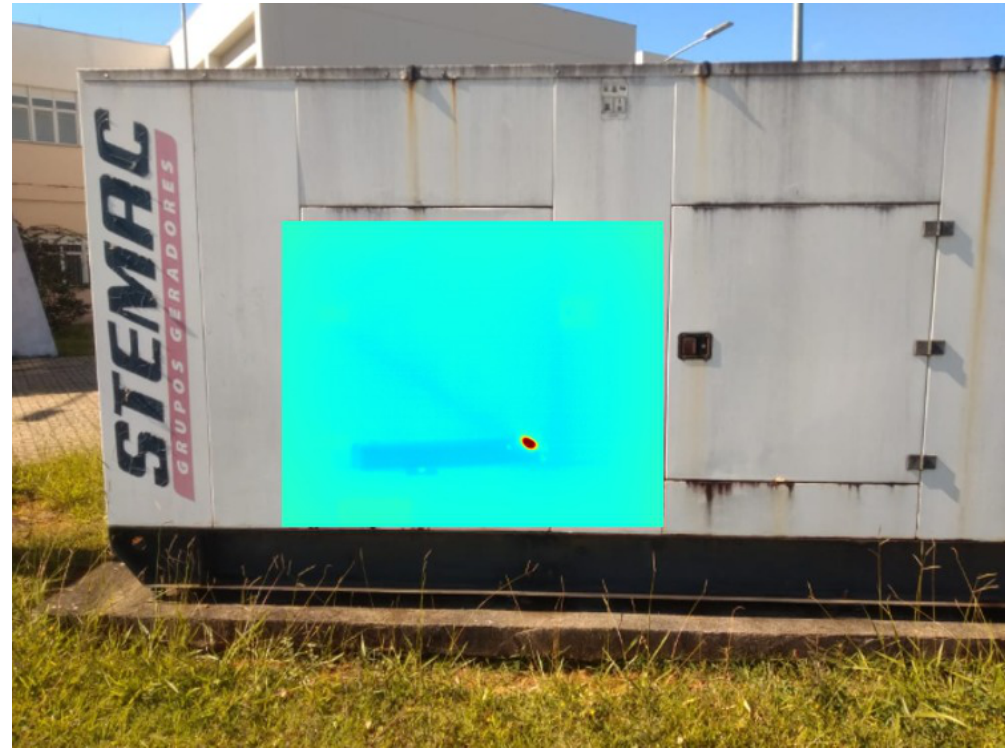
Figure 2. Thermal and Visual homography transformation